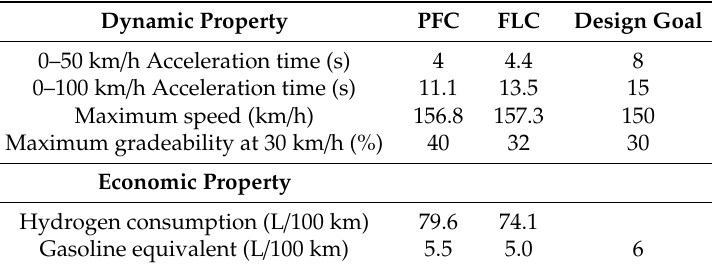
Table 5. Test results of dynamic and economic